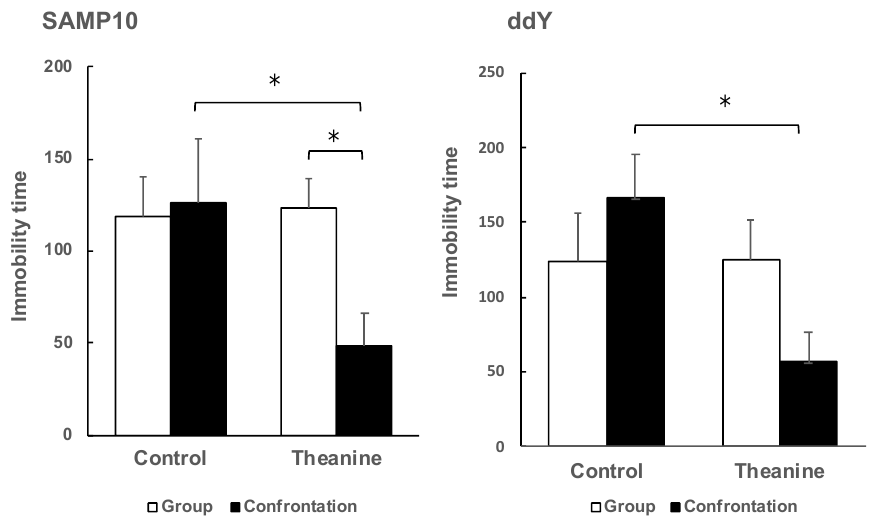
Figure 3. Effect of theanine intake on depression-like behavior of SAMP10 and ddY under group or confrontational housing. Mice were housed confrontationally for one month after single housing for one month (closed column). Group-housed mice were kept in a group of four for two months (open column). Mice ingested theanine (20 µg/mL, 6 mg/kg) or water (control) for two months ( n = 4, *, p < 0.05).